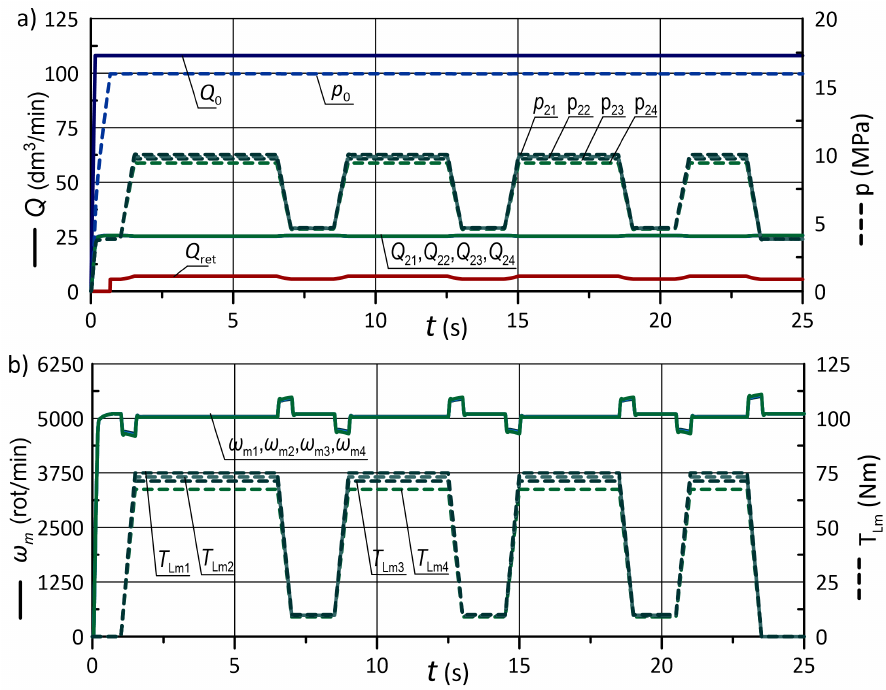
Figure 16. Operating cycle in a high load range, T Lm , max = 75 N m, with load variation of particular motors by 10%; ( a ) flow rates and pressures; ( b ) rotational speed of hydraulic motors and load torques.